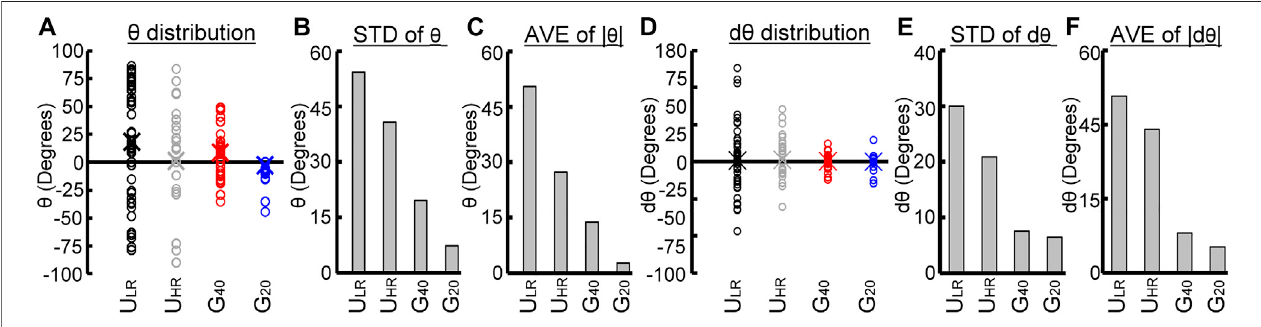
FIGURE6| Comparison ofcellmigratory behaviorsonthefour substrates withdifferent patterns ofsurface roughness. (A) Distributionsoforientationangle ( θ ), (B) standard deviations of θ , (C) average of absolute θ , (D) distributions of change of orientation angle (d θ ), (E) standard deviations of d θ , and (F) average of absolute d θ .